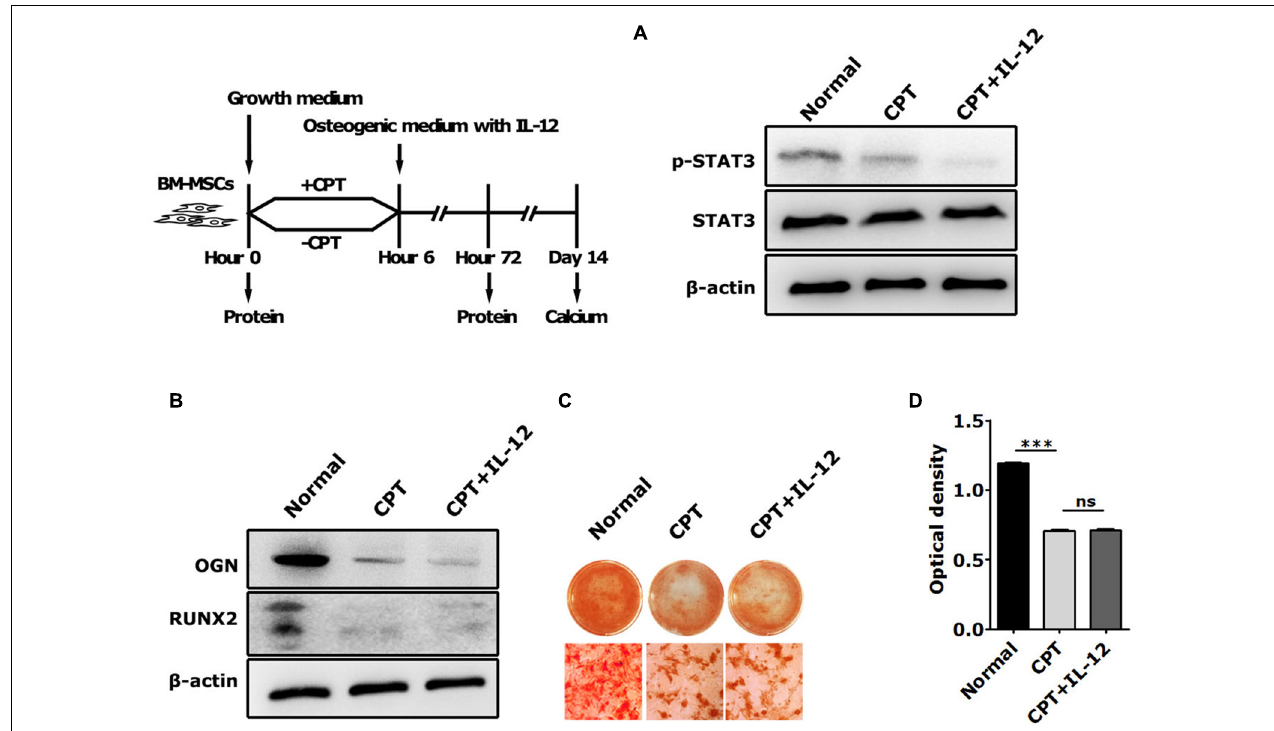
FIGURE 5 | The role of STAT3 activation in IL-12-induced osteogenesis of BM-MSCs. (A) Western blot analysis of STAT3, p-STAT3, and Tyk2 expressions in CPT treated cells co-cultured in osteogenesis inducing medium with or without 0.2 ng/ml IL-12 for 24 h (B) western blot analysis of Runx2, Ogn, Tyk2 expressions in CPT treated cells co-cultured in osteogenesis inducing medium with or without 0.2 ng/ml IL-12 for 24 h (C,D) alizarin red S staining of calcium depositions, the magnifications are 200 × , and quantification of calcium depositions using the assay of colorimetric determination of the dye extraction in cells stained with by alizarin red. The determination absorption wavelength was 562 nm. All the data were presented as the mean ± SEM, n = 3. The results were considered no significant at ns, and were considered significant at *** P <